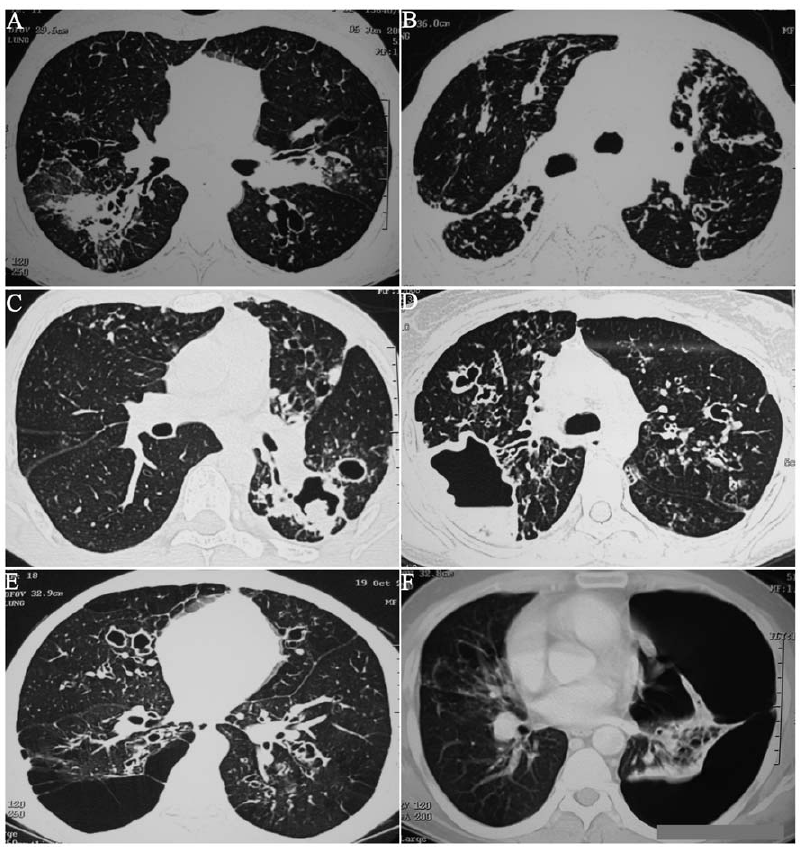
Figure 3. Other radiological features (ORF) that are encountered in patients with allergic bronchopulmonary aspergillosis: (A) parenchymal fibrosis involving the right lower lobe; (B) parenchymal and pleural fibrosis; (C) aspergilloma within a bronchiectatic cavity; (D) large cavity with air fluid level; (E) multiple bulla with central bronchiectasis; (F) left sided pneumothorax- numerous bronchiectatic cavities can be appreciated in the collapsed